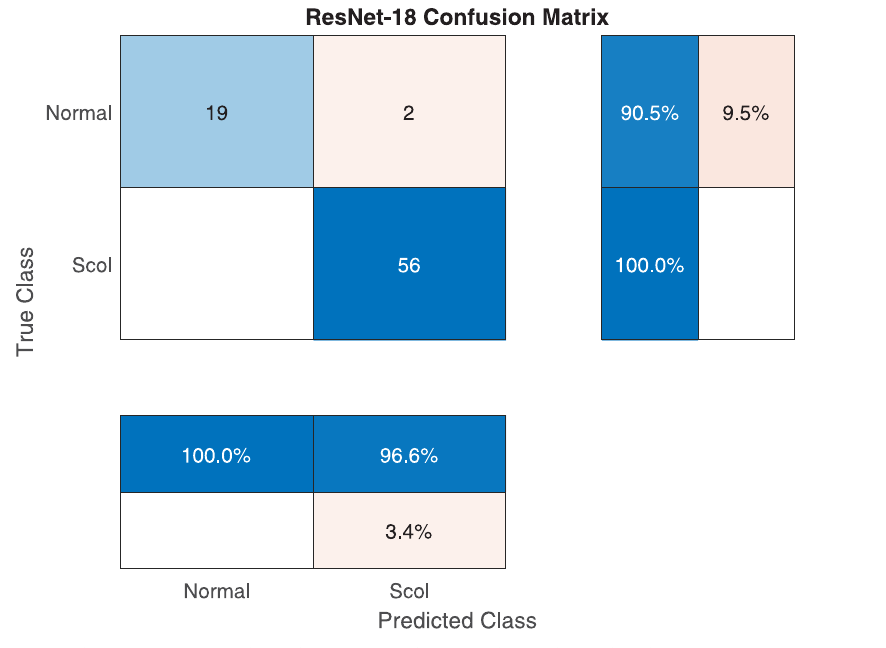
Fig 6. The RestNet-18 sample confusion matrix for normal vs scoliosis classification.